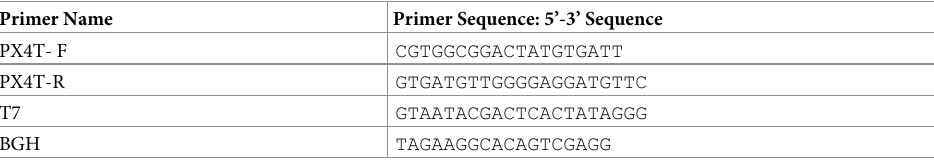
Table 1. List of Primer sequences for